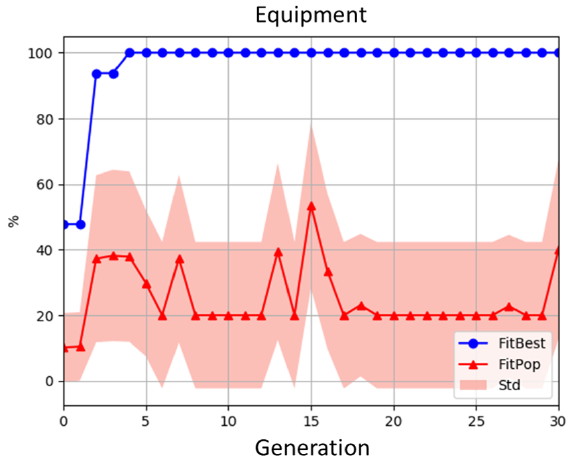
Figure 13. Protected